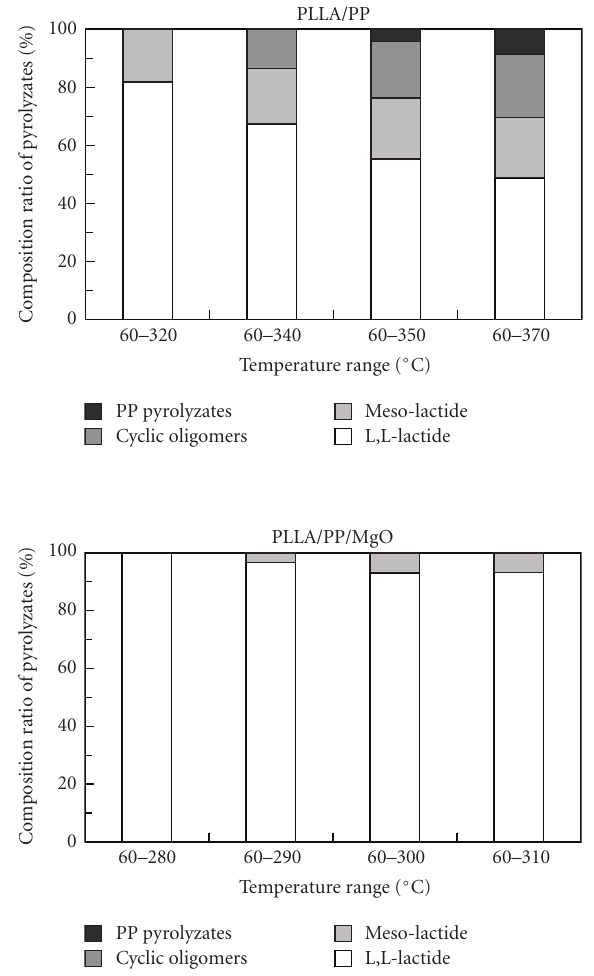
Figure 5: Composition ratios of pyrolyzates from PLLA/PP (80:20wt/wt) and PLLA/PP/MgO (80:20:5 wt/wt/wt).